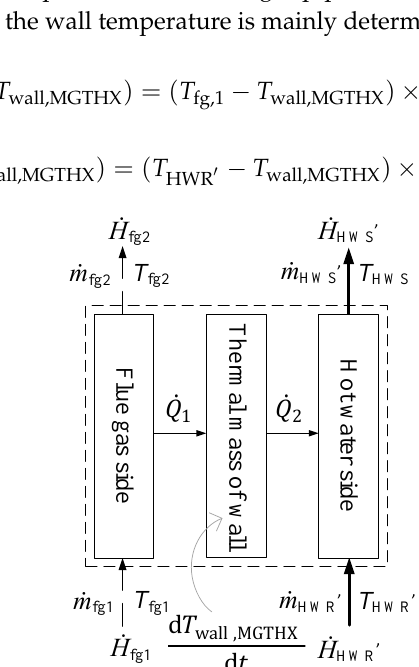
Figure 6. Grey box abstraction of the MGTHX. It consists of a flue gas and hot water pass separated by a